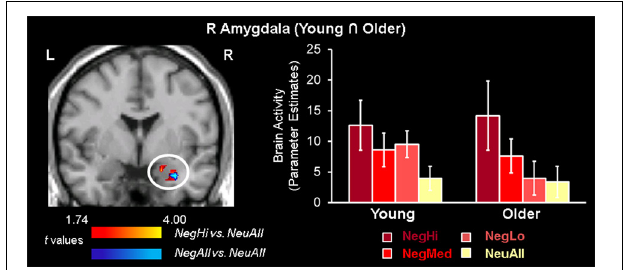
ing a voxel-level threshold of p < 0.05 (FDR-corrected). *Denotes significant difference at a cluster-level threshold of p < 0.05 (FDR-corrected).